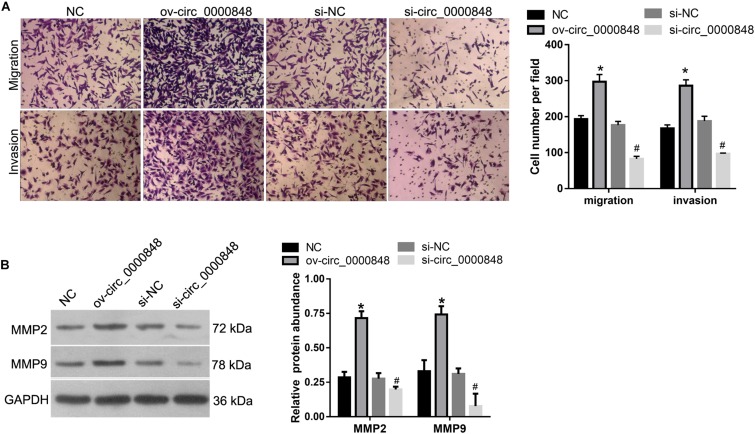
Effect of hsa_circ_0000848 overexpression or knockdown on migration and invasion of HTR-8 cells. (A) The results of transwell assay. The left panel includes representative images of migration and invasion by Transwell assay. The right panel includes bar graphs representing the quantification of migrated or invaded cell numbers. (B) Effect of hsa_circ_0000848 overexpression or knockdown on protein abundance of cleaved caspase-3, cleaved caspase-9, BCL2, and BAX in HTR-8 cells. The left panel includes representative images of western blots. The right panel graphs denote the quantification of relative protein expression levels. *P < 0.05, when compared to NC using unpaired t-tests. #P < 0.05, when compared to si-NC using unpaired t-tests.